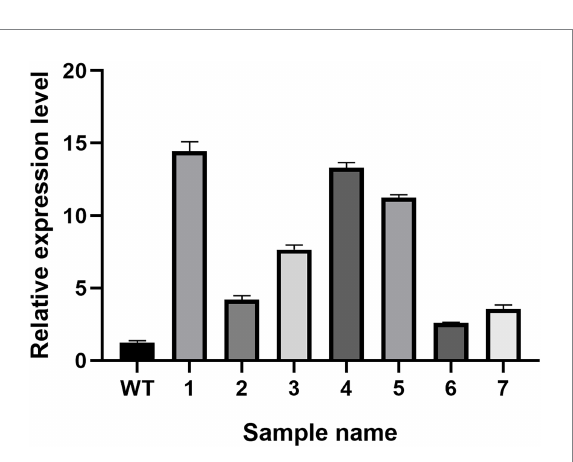
FIGURE 9 The qPCR analysis of transformants in L.